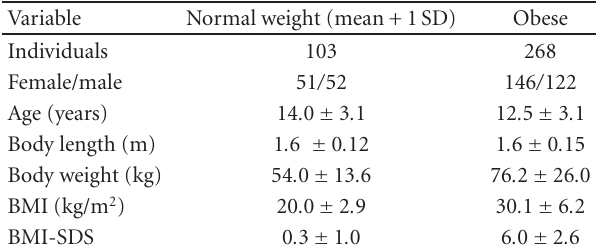
Table 1: Baseline characteristics of study participants (age range 5 to 20 years, n = 371).